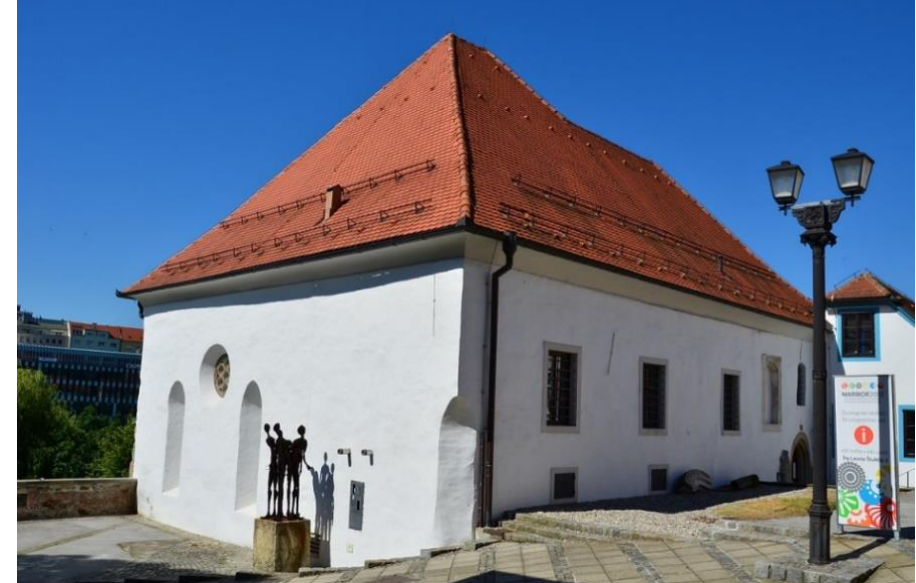
Figure 1. Maribor Synagogue, view from the northeast. Exterior. Photo: Janez Premk.